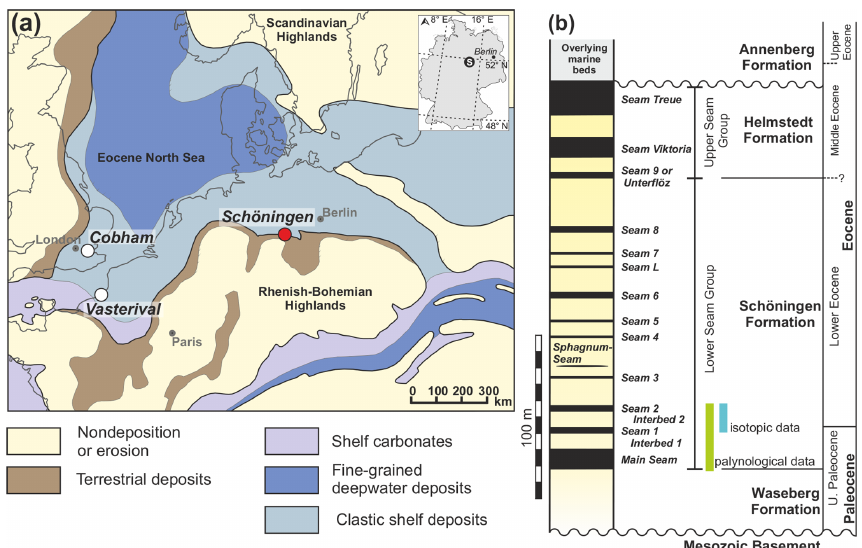
Figure 1. (a) Paleogeographic map of northwestern Europe during the early Eocene (adapted from Ziegler, 1990) showing the locations of the Schöningen opencast mine (D), Cobham (UK), and Vasterival (F). (b) Schematic stratigraphy of the Schöningen area (adapted from Brandes et al.,